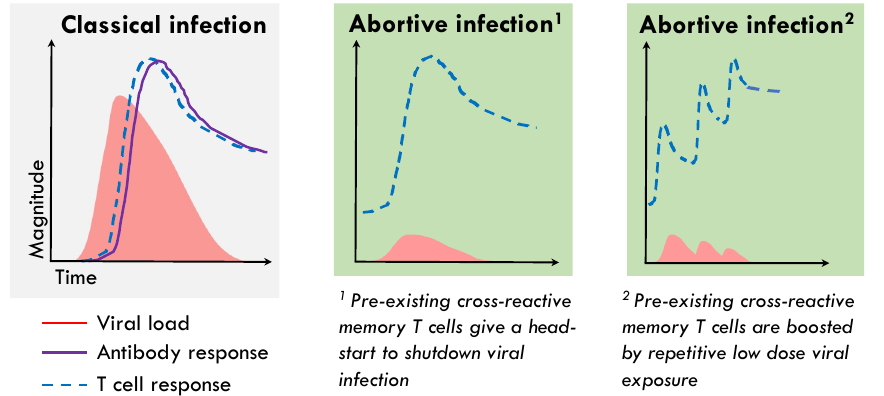
Figure 2. Schema of pre-existing memory T cells aborting infection without seroconversion. During classical acute-resolving virus infections there is a delay between infection and detection of both systemic virus-specific antibodies and T cells, as rare naïve precursors are recruited to the area of infection and draining lymph nodes where they go through several rounds of proliferation, which allows the virus time to exponentially replicate. Due to the association of abortive infection with the presence of pre-existing memory T cells targeting the replication-transcription complex of SARS-CoV-2, we hypothesis that these T cells could be rapidly recruited to, or be present at, the site of infection in the airways and can perform immediate effector functions blunting viral replication before infection is established. This could occur following a single exposure ( 1 ) or due to low dose repetitive viral exposure ( 2 ), both of which would result in absence of detectable infection or seroconversion, but the expansion of SARS-CoV-2 specific T cells.